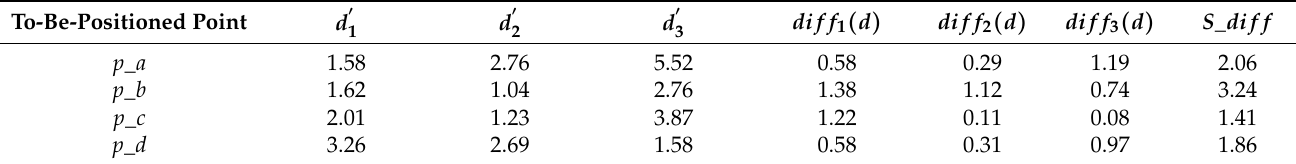
Table 4. The classic LDPLM ranging results and errors (m).